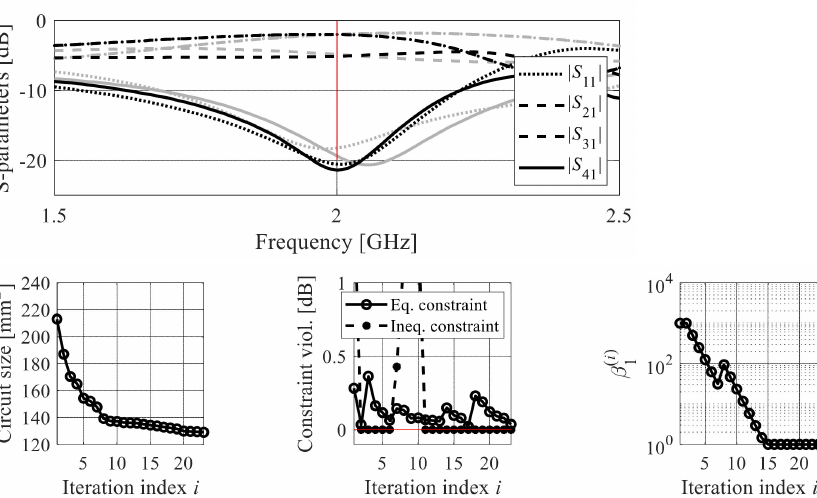
Figure 20. Initial (gray) and optimized (black) S-parameters of Circuit II. The vertical and horizontal lines mark the target operating bandwidth and the acceptance level for the matching | S 11 | and isolation | S 41 | responses. Additionally, shown is the evolution of the circuit size and constraint violations (in case of feasibility, violations shown as zero), as well as evolution of the penalty coefficient for the inequality constraint. The vertical line shows the target operating frequency of 2.0